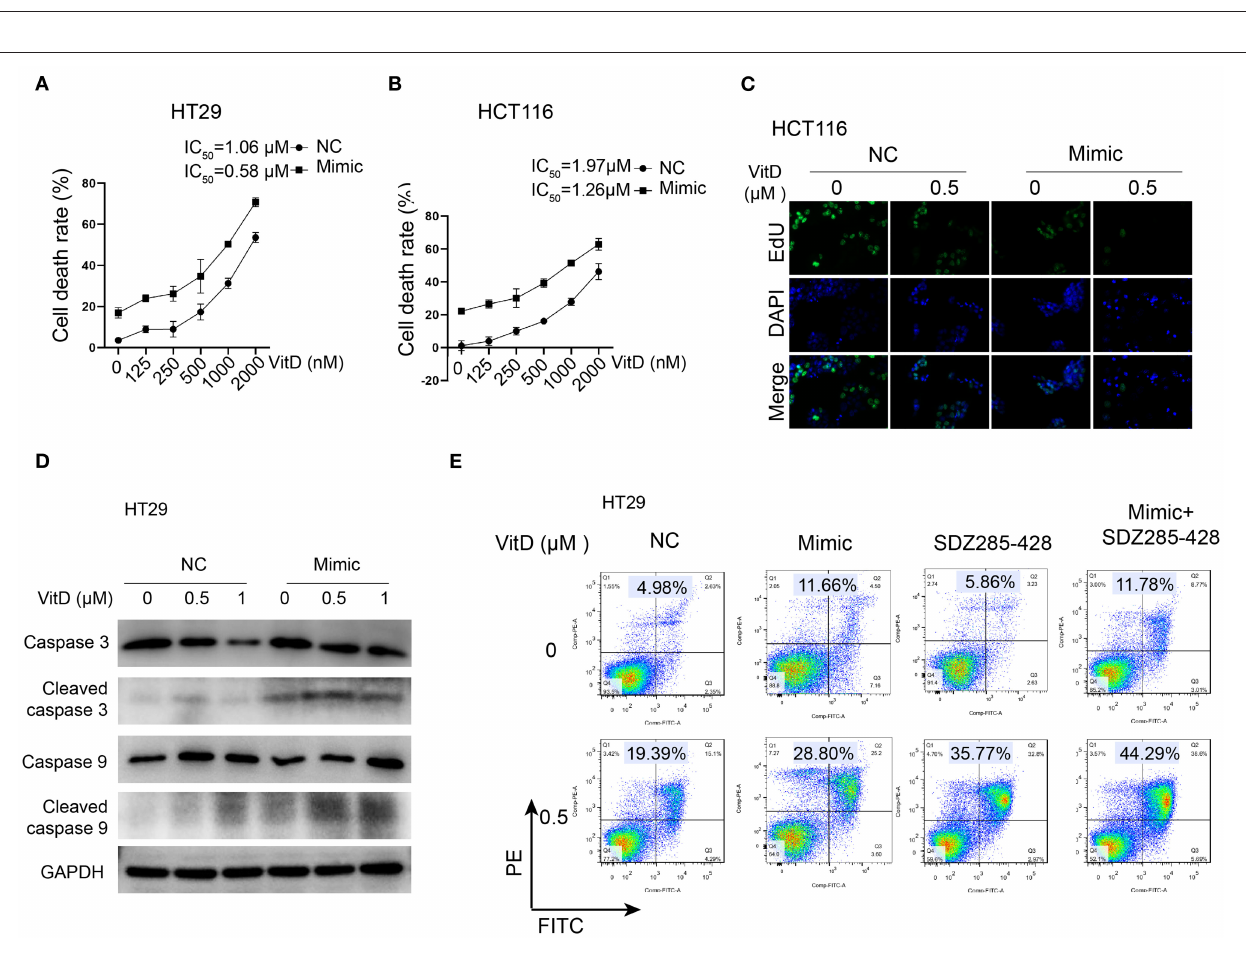
FIGURE 6 | miR-1278 sensitizes CRC cells to vitamin D by depressing the expression of CYP24A1. (A,B) Cell viability was detected by CCK-8 assay in HT29 and HCT116 cells treated with various concentrations of vitamin D for 24h. The IC50 values of the NC and miR-1278 mimic groups were 1.06 and 0.58 µ M, respectively, in HT29 cells and 1.91 and 1.26 µ M, respectively, in HCT116 cells. (C) Transfection of miR-1278 markedly inhibited the proliferation of HCT116 cells treated with 0.5 µ M vitamin D as demonstrated by the EdU assay. (D) The expression of cleaved caspase 3 and cleaved caspase 9 was increased in the miR-1278 mimic group compared to the control group after treatment with the same concentration of vitamin D. (E) SDZ285-428 is a specific inhibitor of CYP24A1. Either the miR-1278 mimic or SDZ285-428 led to an improved apoptosis rate after vitamin D treatment, and the combination treatment of the miR-1278 mimic and SDZ285-428 resulted in a further enhancement of apoptosis in HT29 cells. VitD, Vitamin D; NC, negative control; Mimic, miR-1278